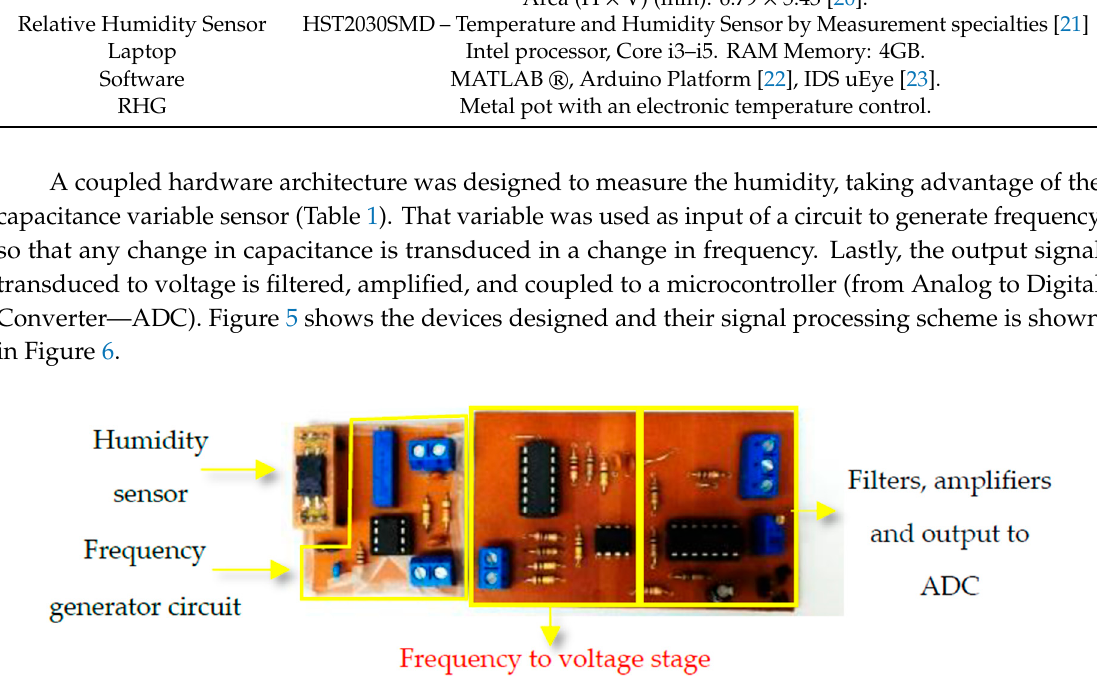
Figure 5. Designed board to add humidity signal to the microcontroller (ADC). Source: Authors.